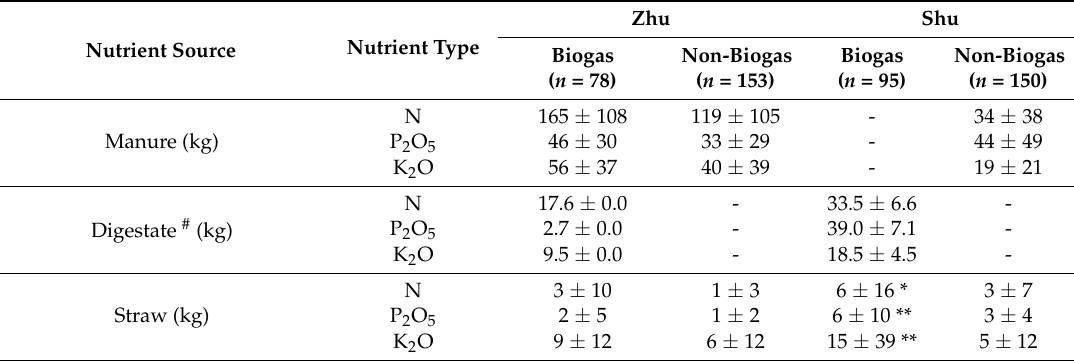
Table 5. Cropland nutrient applications for biogas and non-biogas households in two villages, expressed per household over a 12-month